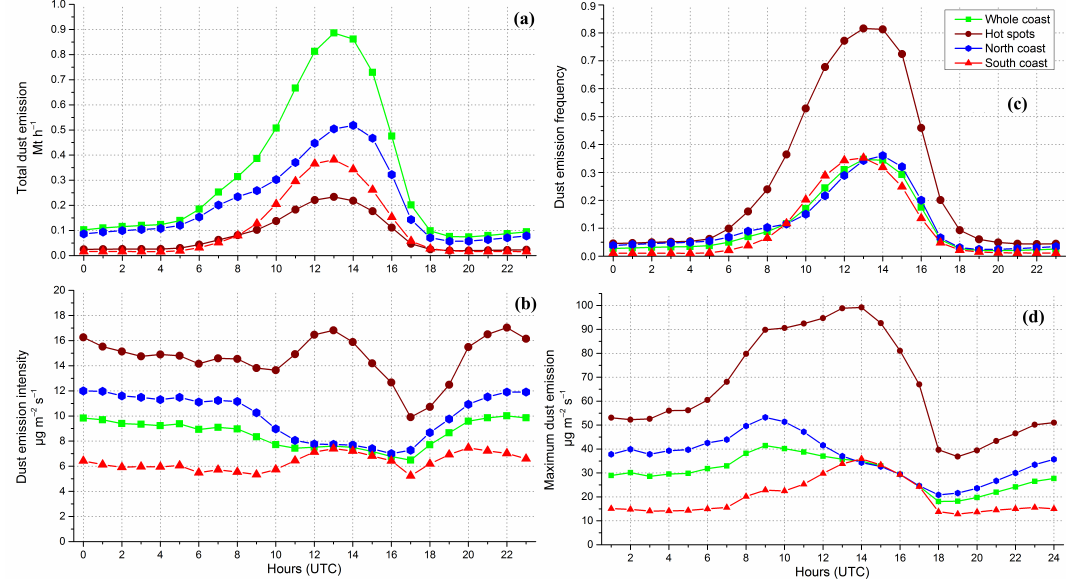
Figure 8. Annual mean diurnal cycles of (a) total dust emission (Mth − 1 ), (b) dust event frequency, (c) average emission intensity (µgm − 2 s − 1 ), and (d) maximum emission rate (µgm − 2 s − 1 ) in 1kmALL experiment with SEVIRI source function